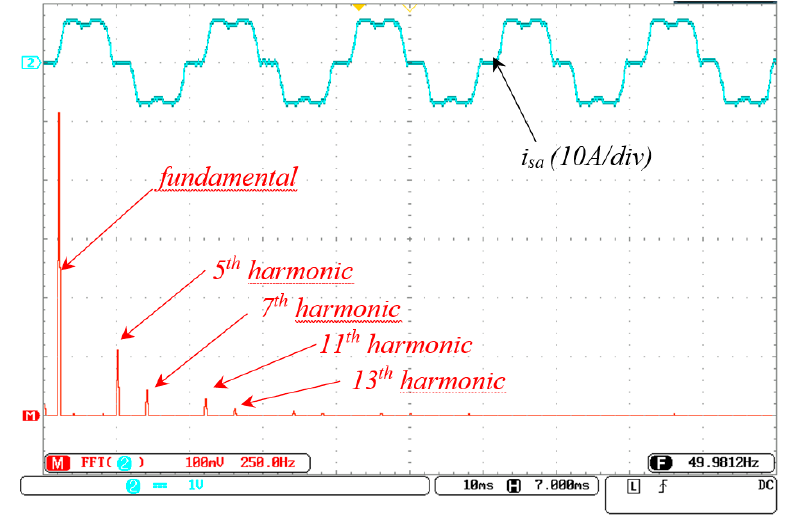
Figure 10. FFT analysis of supply current before connecting the filter.